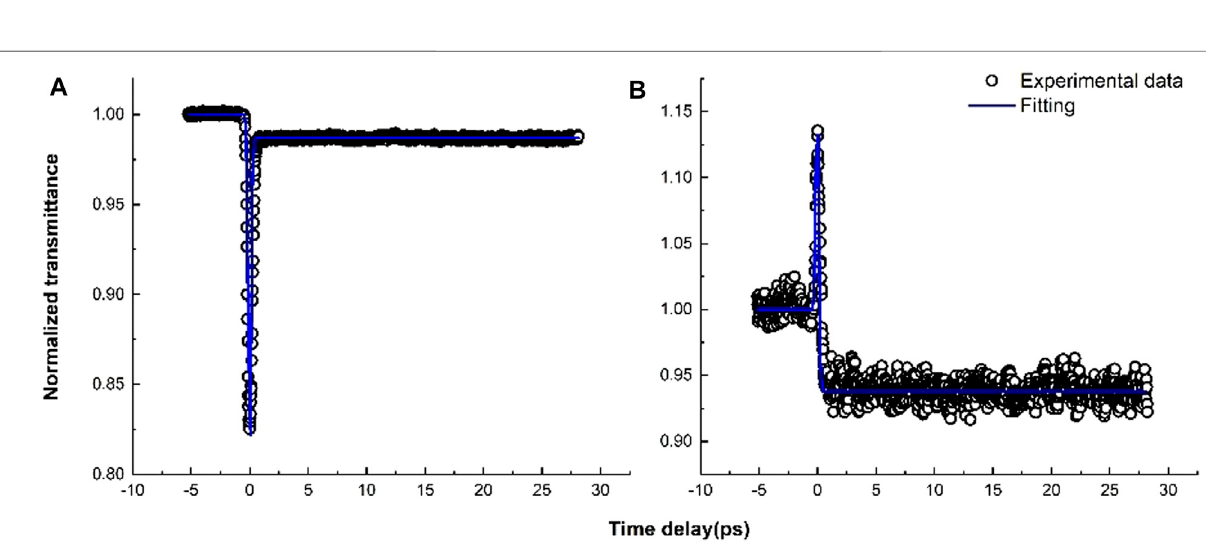
FIGURE 2 | Nonlinear absorption curves (A) and nonlinear refraction curves (B) of β -Ga 2 O 3 : Sn at 355 nm pump and 515 nm probe.